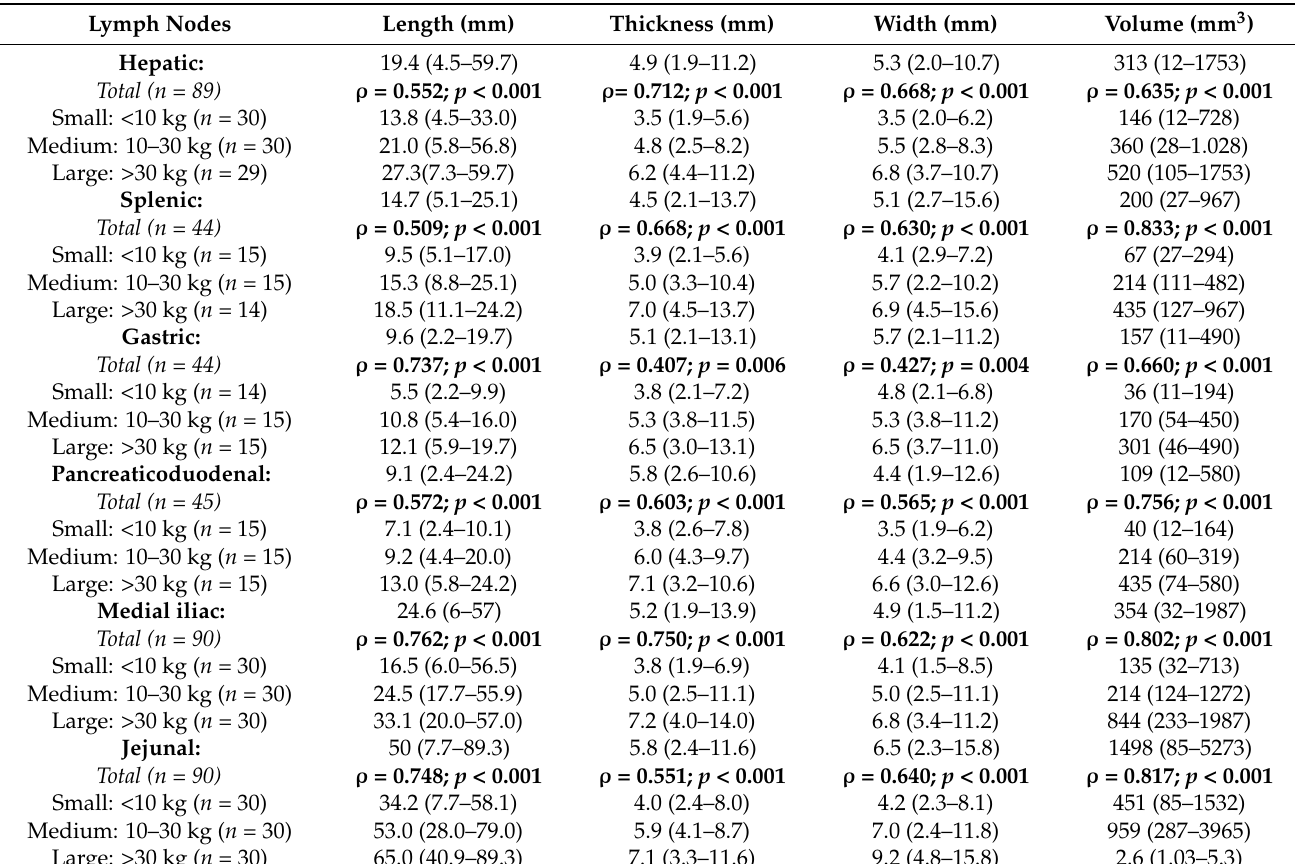
Table 1. Median and range (within parentheses) values of ALs size according to body weight categories. Data are stratified by